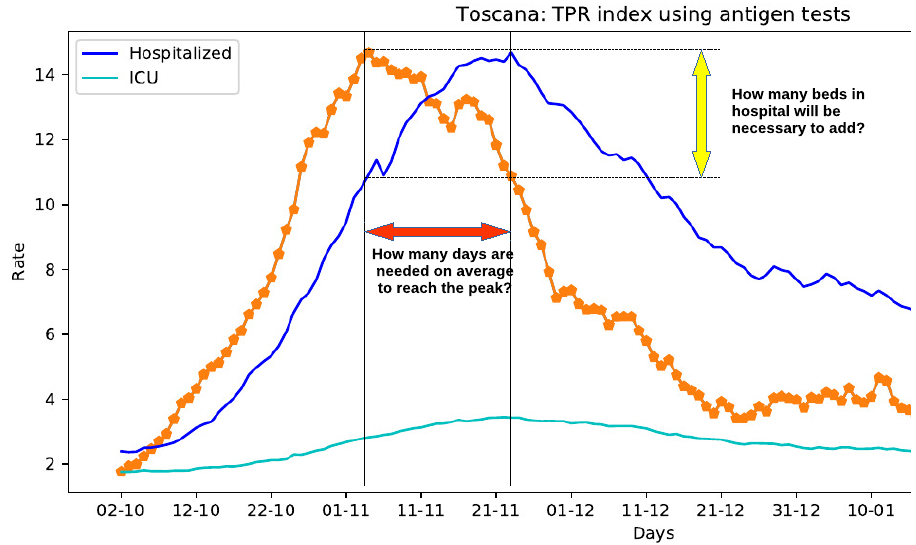
Figure 1. The Test Positivity Rate (TPR) index (orange dotted line) predictive